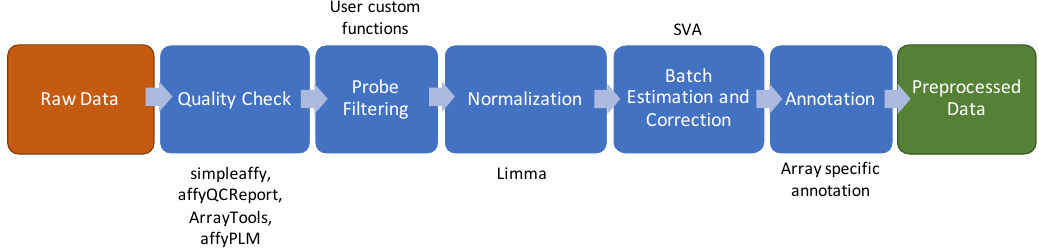
Figure 1. Data preprocessing schema for microarray. The brown box indicates the input of the pipeline. The green box indicates the output of the pipeline. The blue boxes show the intermediate steps of the pipeline and above or below the boxes are listed the software/packages employed in the